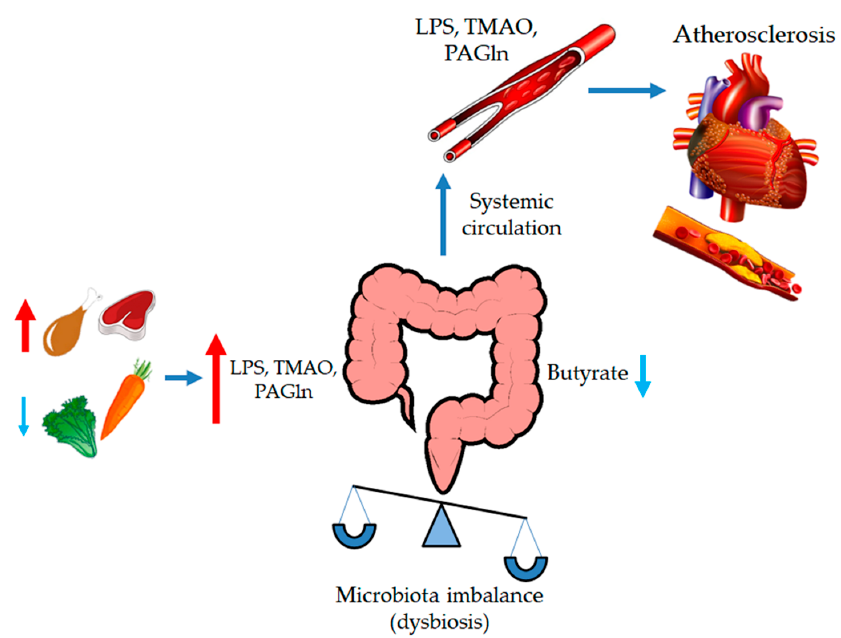
Figure 5. Microbiota dysbiosis promotes atherosclerosis formation. An obesogenic diet is rich in